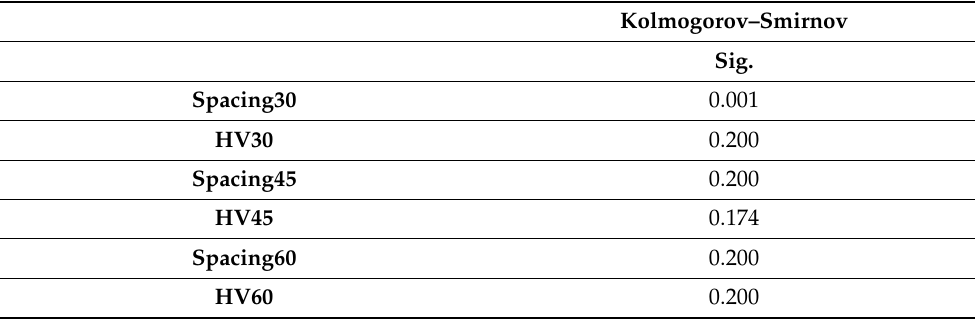
Table 6. Normality Test of samples used by all other algorithms except the Multi-Objective Whale Optimization Algorithm